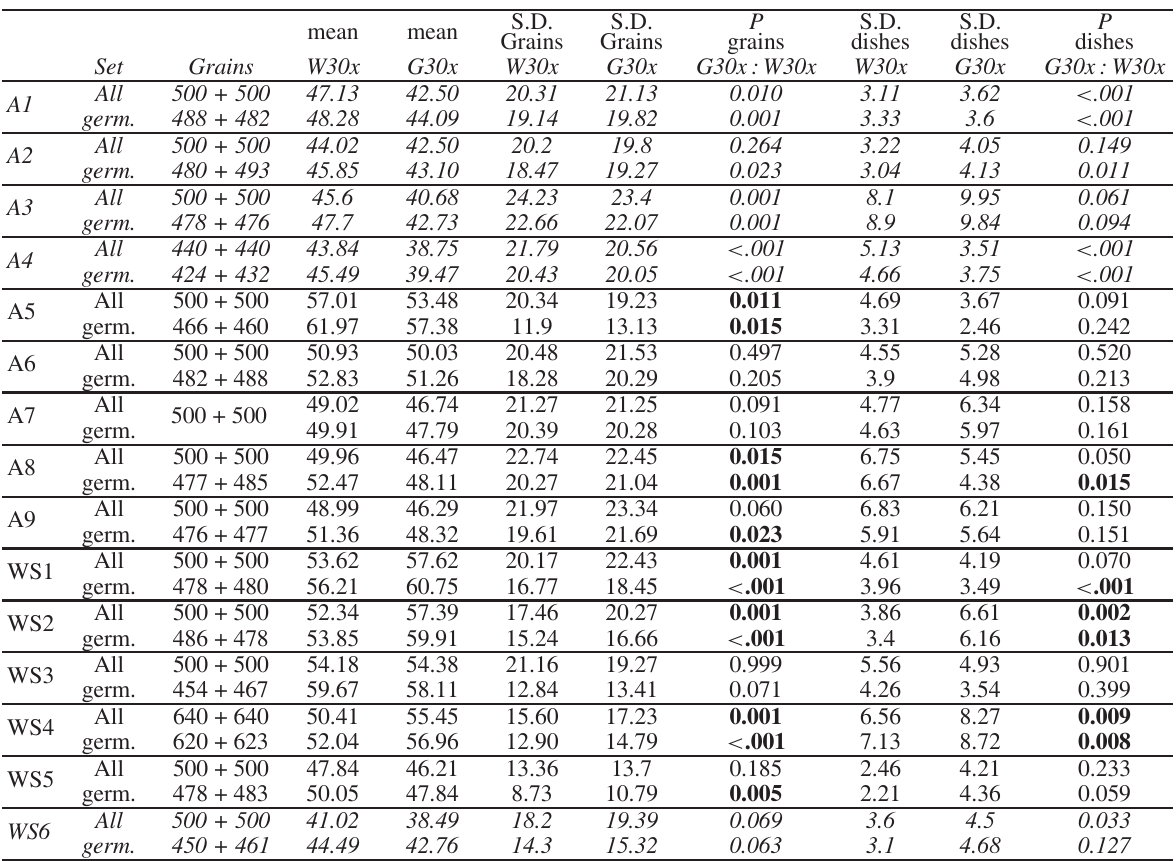
TABLE 2: Germination rates of wheat after 7 days under the influence of extremely diluted agitated gibber- ellic acid (30x) and control. For details, see Table 1. Series ( N ) All autumn exp. All winter/spring exp. TABLE 3: Overview of results of stalk length measurement in the experiments listed in Table 1, each shown for “all grains”: all treated grains (upper line) and “germinated grains only”: only those grains which germinated during the 7 days of the experiment (lower line). Mean W30x: mean stalk length in the W30 group (in mm); mean G30x: mean stalk length in the G30x group; S.D.: standard deviations: “grains”: at grain level (i.e., S.D. of 500 values), “dishes”: at dish level (i.e., S.D. of 20 or 25 values). P : significance level of differences between groups at grain level and dish level.